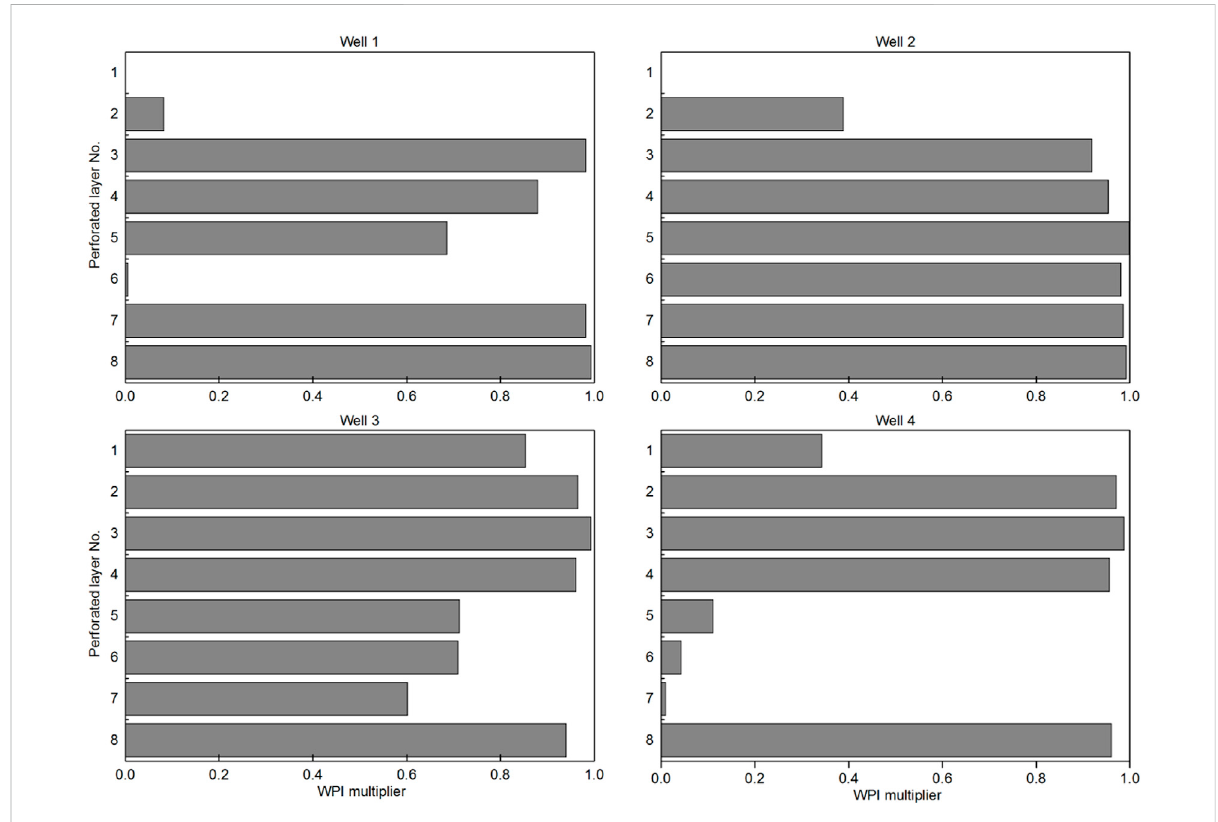
FIGURE 16 WPI multipliers for perforations of the four in fi ll wells, Case